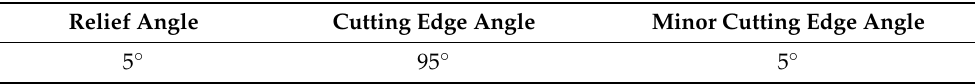
Table 3. Geometry parameters of the tool holder with the insert.